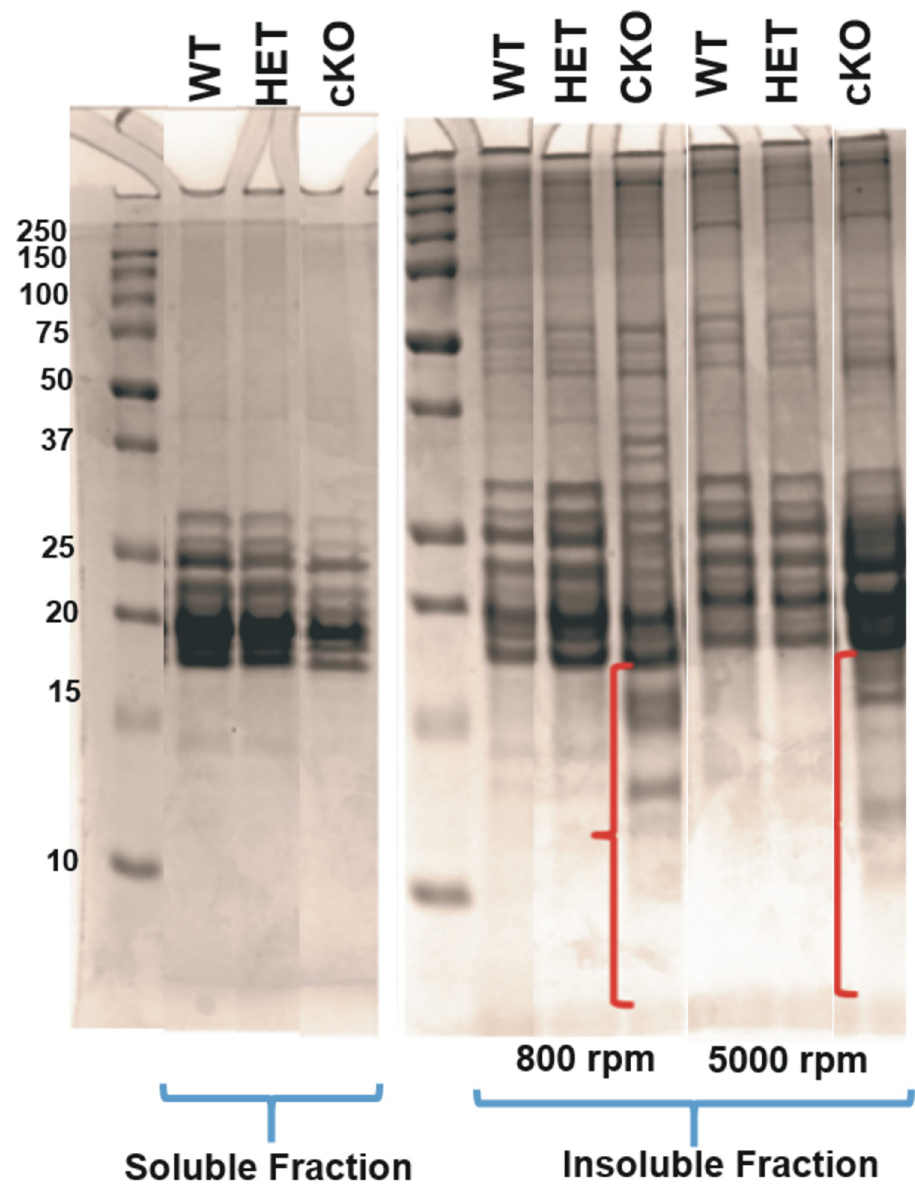
Fig 2. SDS-PAGE analysis of insoluble and soluble protein fractions from lenses of wild type, β A3 heterozygous and β A3cKO mice. SDS-PAGE analysis of insoluble protein fractions recovered after 800 rpm and 5000 rpm centrifugations, and the soluble fractions remaining after the two centrifugations from lenses of wild type, β A3 heterozygous and β A3cKO mice. The protein fragments ( < 20 kDa, identified by red brackets) were analyzed by mass spectrometry to identify the parent proteins from which the fragments were